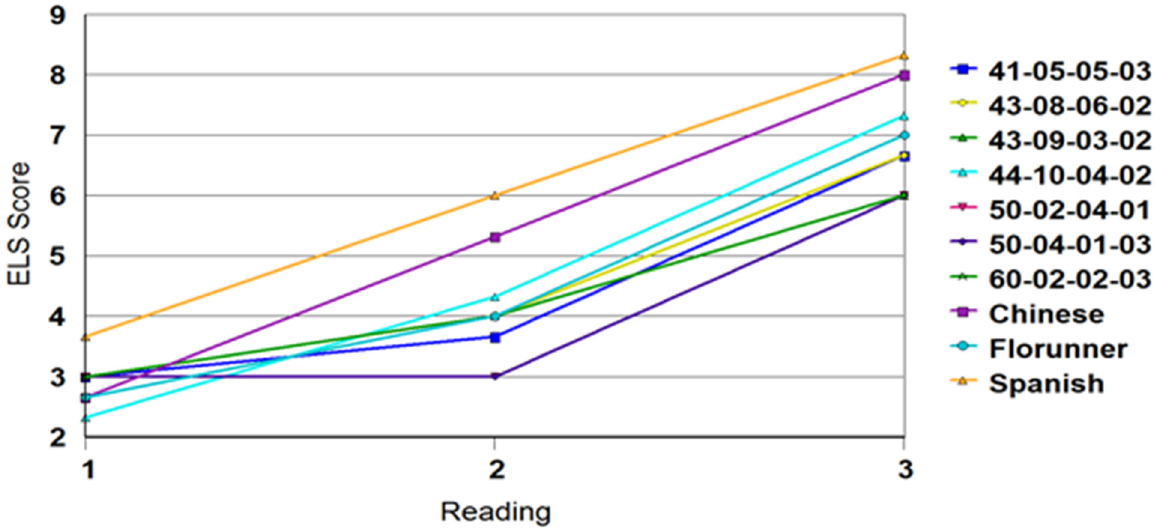
Figure 2. Disease ratings for early leaf spot using the Florida scale. Rating dates were after those used for the time course for development of symptoms, and were taken at 2-week intervals.